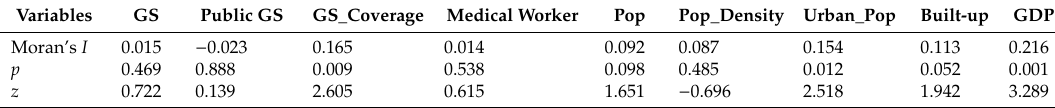
Table 3. Global Moran’s I of control variables in